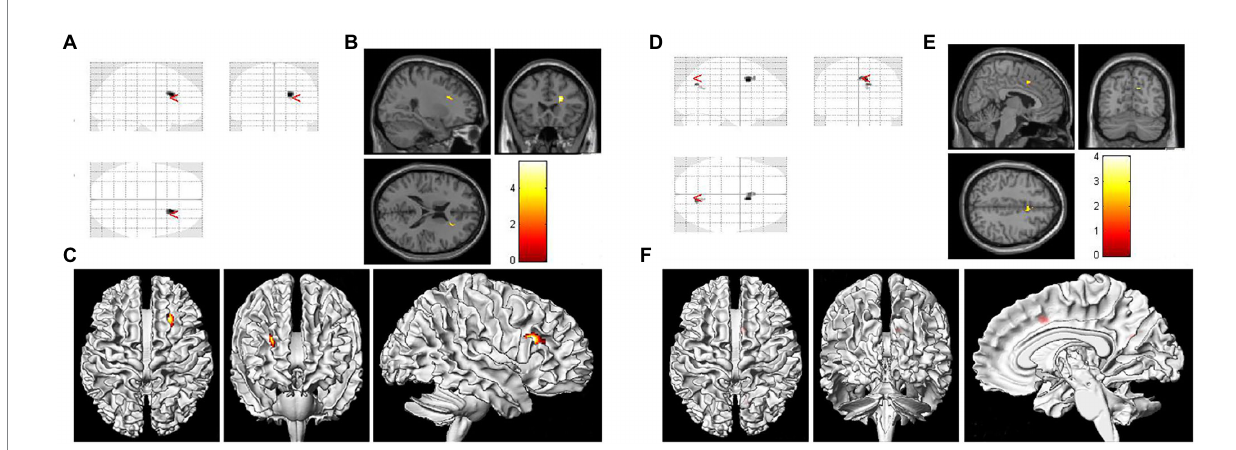
FIGURE 1 Voxel-based morphometry (VBM) results of gray matter atrophy and white matter lesions in asymptomatic patients with right severe carotid artery stenosis compared with healthy controls. (A,D) Statistical parametric mapping (SPM) results in various brain regions. (B) Significantly decreased white matter volume was found in the right subgyral region ( p < 0.05). (E) Gray matter atrophy was found in the right occipital lobe precuneus and right occipital lobe cuneus ( p < 0.05). (C,F) Three-dimensional images of the asymptomatic patient with right severe carotid artery stenosis.